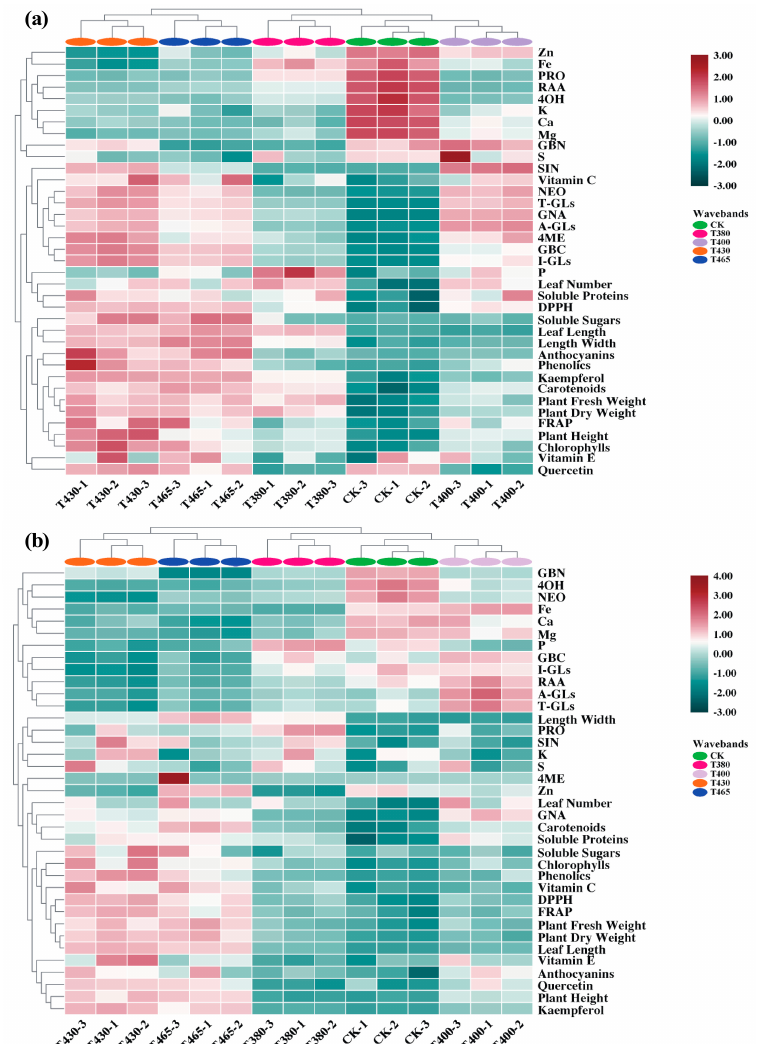
Figure 5. Cluster heatmap analysis summarizing two baby-leaves response to supplementary blue and UV-A wavebands. ( a ) Chinese kale and ( b ) Pak-choi response patterns. Results are visualized using a false color scale with red indicating an increased parameter, and green indicating a decreased parameter. DPPH = 2,2-diphenyl-1-picrylhydrazyl radical scavenging, FRAP = ferric reducing antioxidant power, A-GLs = aliphatic flucosinolates, I-GLs = indolic glucosinolates, T-GLs = total glucosinolates, PRO = progoitrin, RAA = glucoraphanin, SIN = sinigrin, GNA = gluconapin, GBN = glucobrassicanapin, 4OH = 4-hydroxyglucobrassicin, GBC = glucobrassicin, 4ME = 4-methoxyglucobrassicin, NEO = neoglucobrassicin, P = phosphorous, K = potassium, Ca = calcium, Mg = magnesium, S = sulphur, Zn = zinc, Fe =